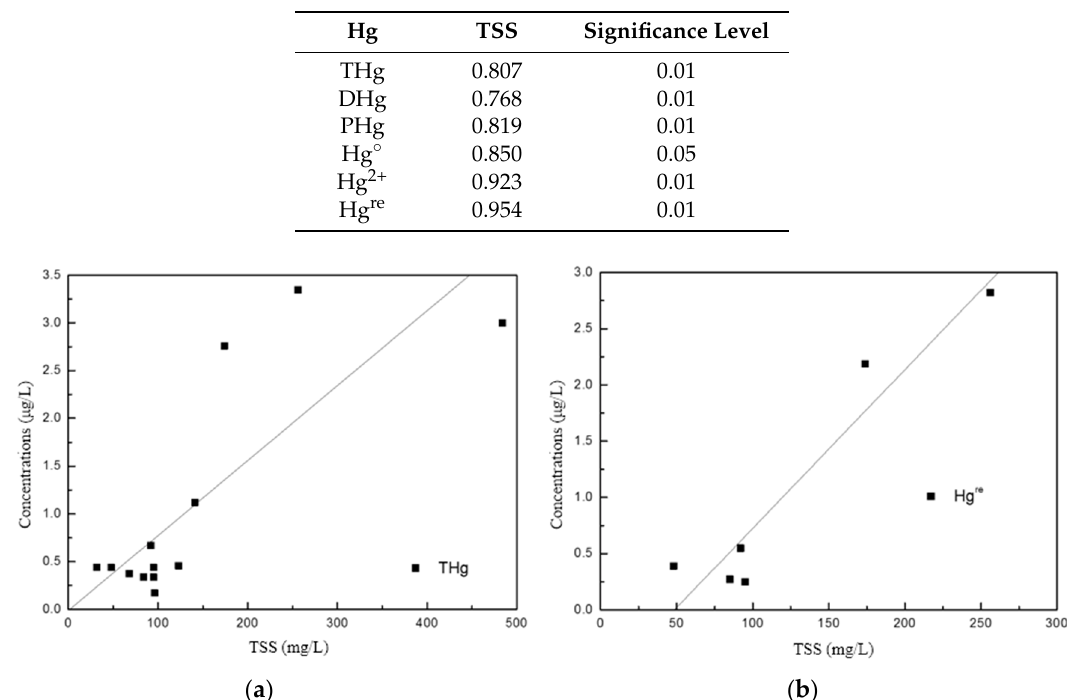
Figure 4. Cluster analysis of different Hg species and characteristics of rainfalls.